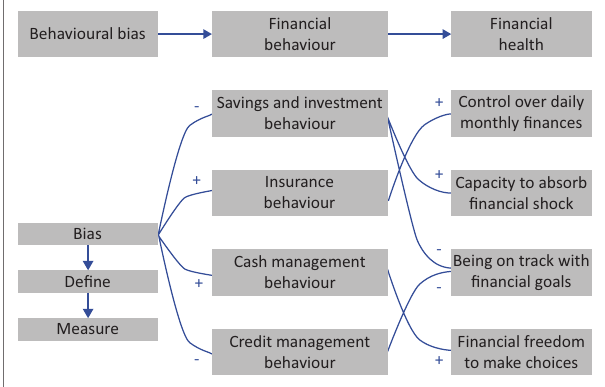
FIGURE 1: The relationship between behavioural biases, financial behaviours and financial